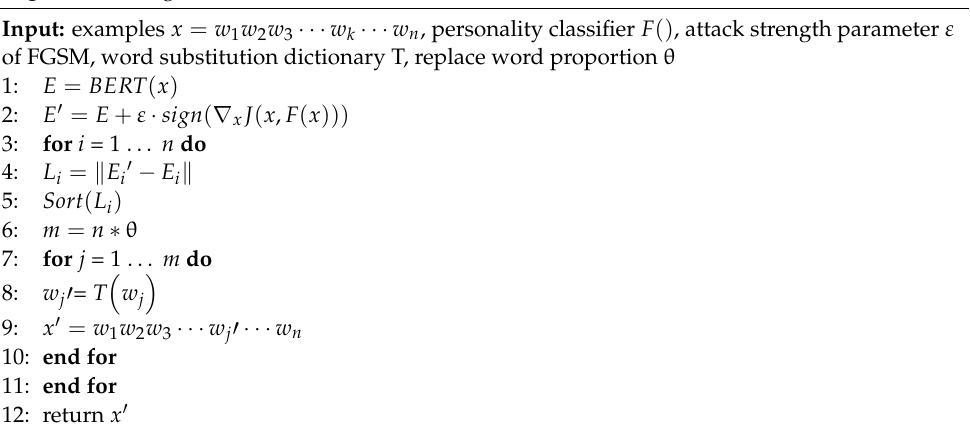
Algorithm 1. Algorithm for the SCRS